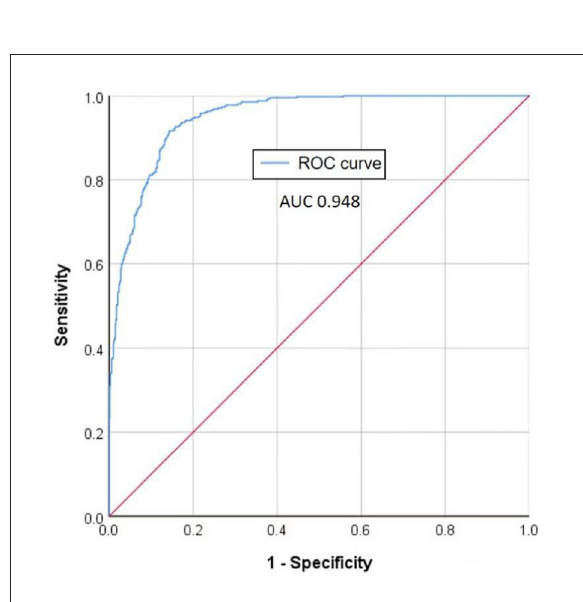
FIGURE4 ROC curve of the training set of the developed DL